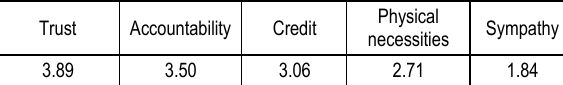
Table 2. Average rank of hypotheses indexes